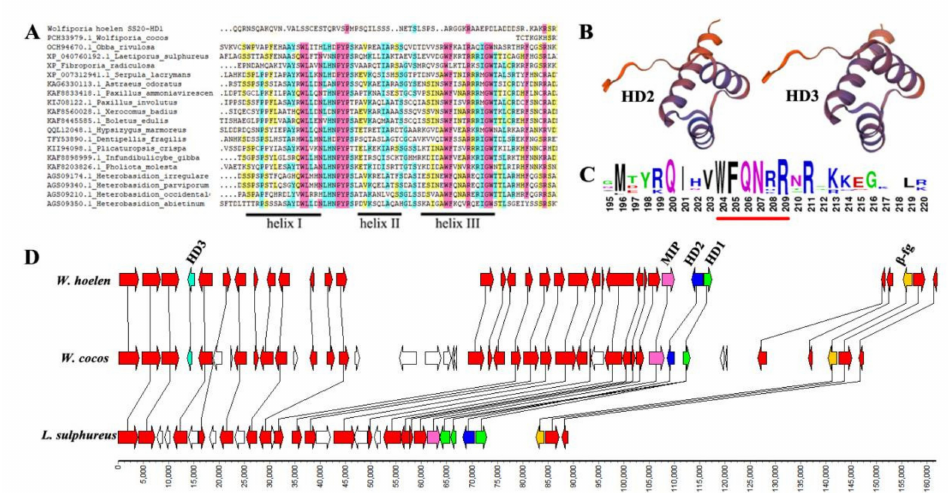
Figure 6. Structure analysis of HD proteins and collinearity of MAT-A and surrounding genes among W. hoelen , W. cocos , and L. sulphureus. ( A ) Multiple sequence alignment of HD1 proteins and conserved helix structures; ( B ) Three-dimensional structure of the conserved domain of HD proteins; ( C ) Conserved specific motif of HD2; ( D ) Collinearity of MAT-A and its surrounding genes among W. hoelen , W. cocos , and L. sulphureus